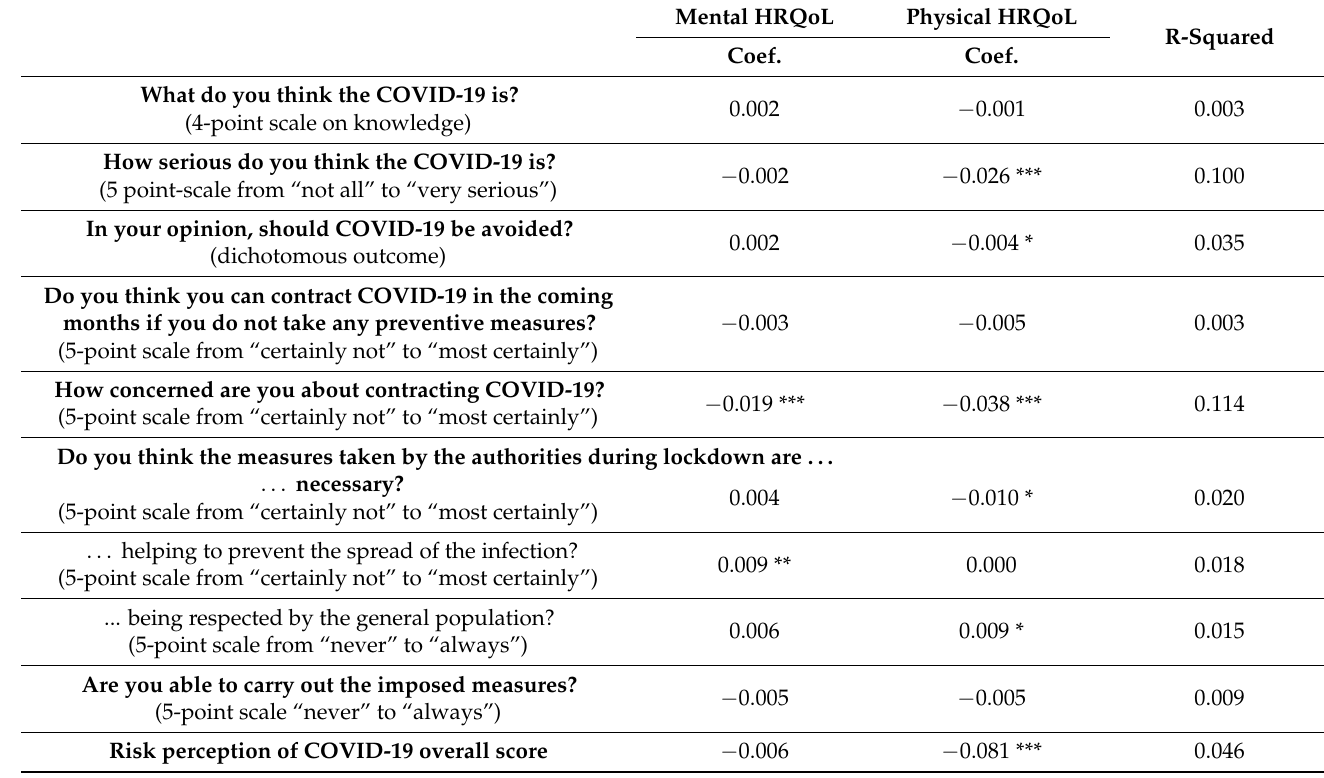
Table 3. Multivariate regression results of mental and physical HRQoL scores for risk perception of COVID-19.